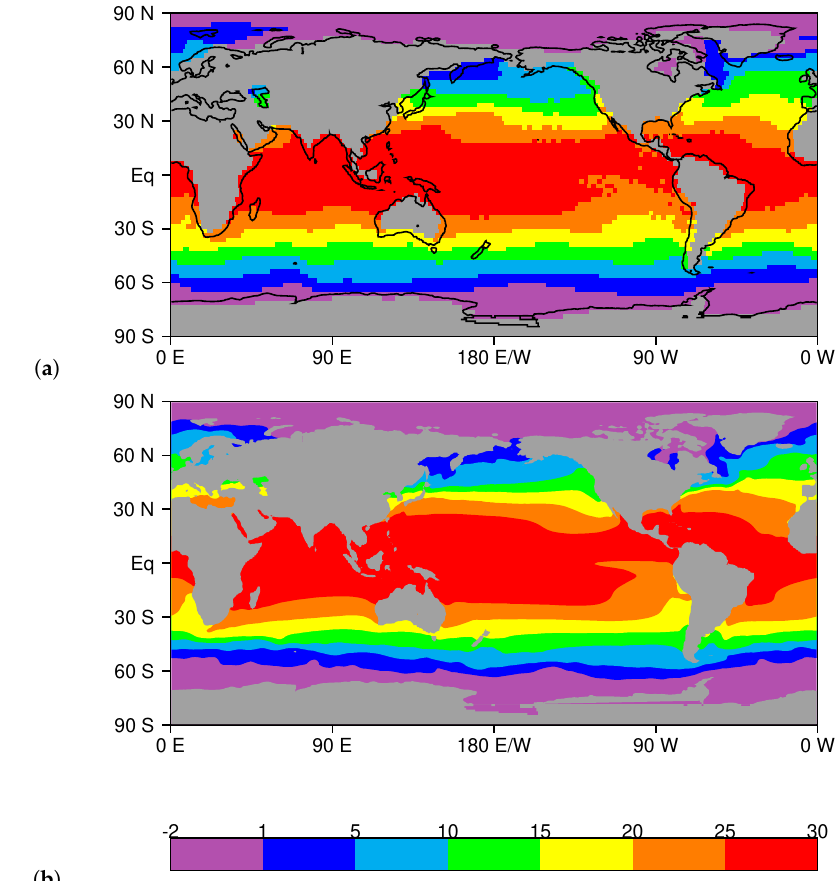
Figure 2. Comparison of simulated and observed sea surface temperatures (SSTs). ( a ) Annual average SST for years 1–10 of the LCM simulation. ( b ) Observed annual average SST from the NCEP Optimally Interpolated weekly SST and Sea Ice Data for